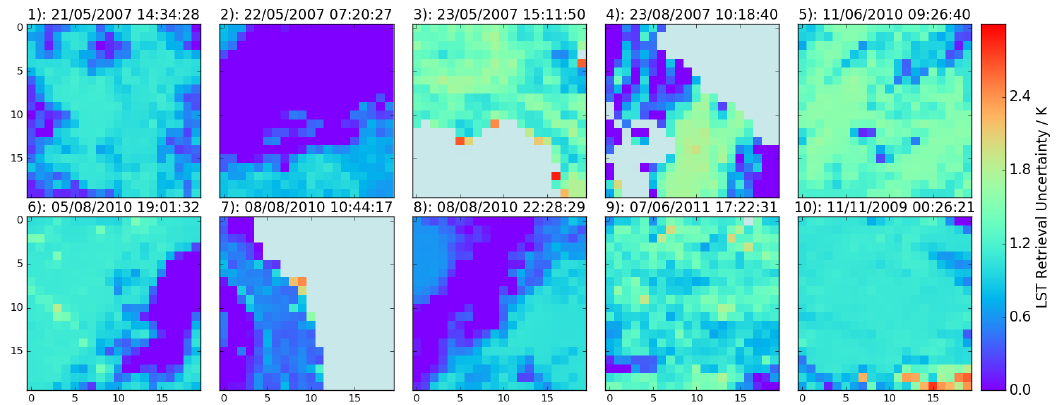
Figure 3. Level 3 LST retrieval uncertainties for the 10 submission scenes in the cloud clearing inter-comparison (Table 1) at 625-km 2 resolution. Individual plot headings give the scene number, date and orbit start